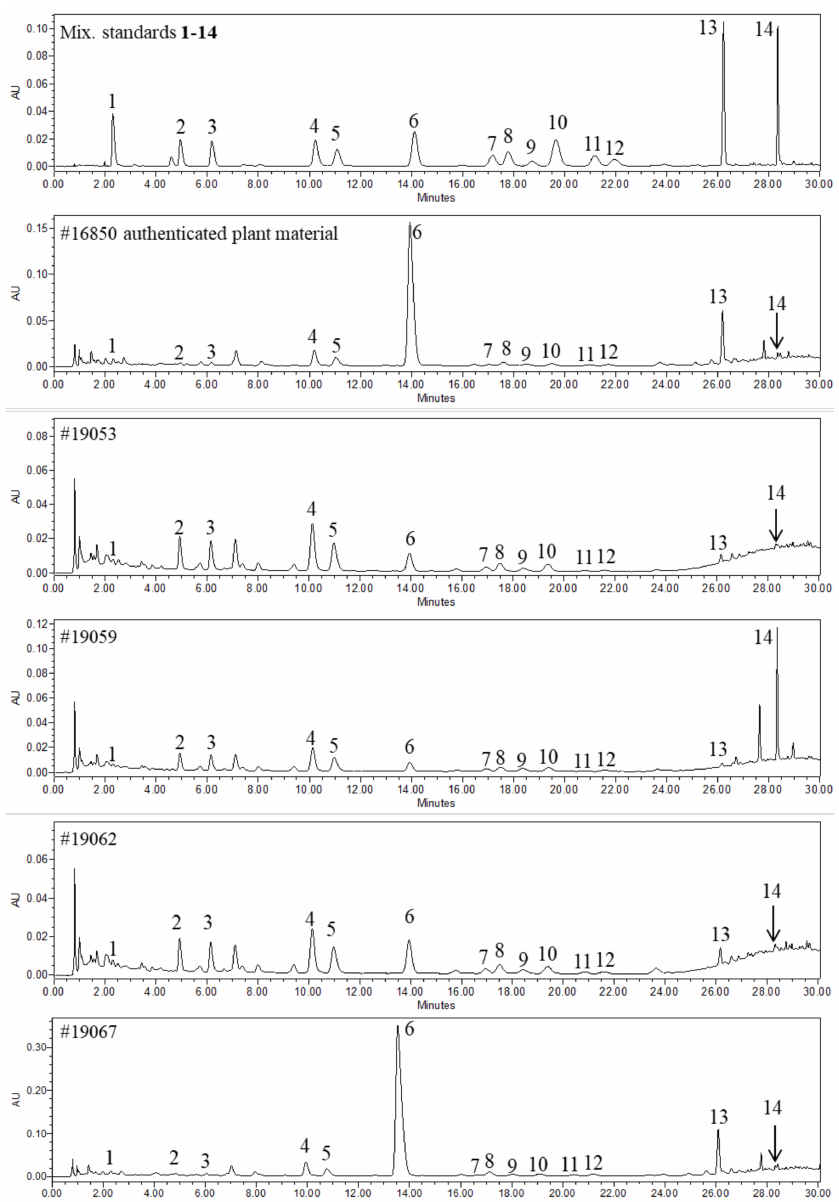
Figure 2. UHPLC-UV Chromatograms of a standards mixture ( 1 – 14 ), authenticated plant sample (#16850) and dietary supplements (#19053, #19059, #19062, and #19067) at 288